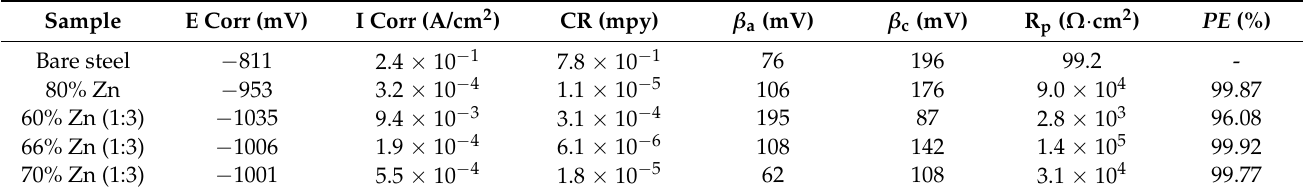
Table 4. The electrochemical parameters of bare steel substrate and ZRP coatings.